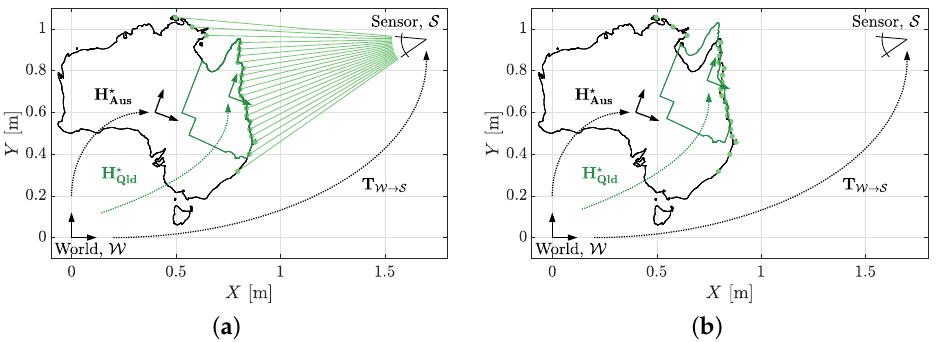
Figure 20. Models of Australia (black) and Queensland (green) fit to a point cloud measurement set. ( a ) The MSOE algorithm is able to locate both geometries, however ( b ) the ICP algorithm is unable to locate the Queensland model without prior segmentation of the point